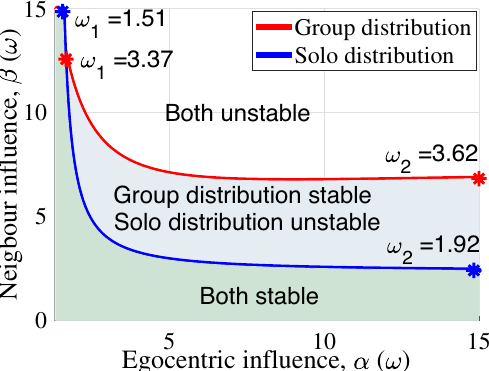
Figure 7. Stable and unstable regions for the two delay distributions (solo and group) were discovered by applying Eqs. (32) and (33) describing the stability boundary in terms of an individual agent’s ego influence α and neighbor influence β . Low neighbor influence factors lead to stable swarm center positions (green region) for either case. As neighbor influence grows, the swarm using a solo distribution loses stability (blue region) before the swarm using group behavior delays loses stability (white region), indicating that the group distribution provides a larger range of response weights (gains) that lead to a stable swarm. As the egocentric weight α grows on the stability boundary, the transition oscillation frequency ω